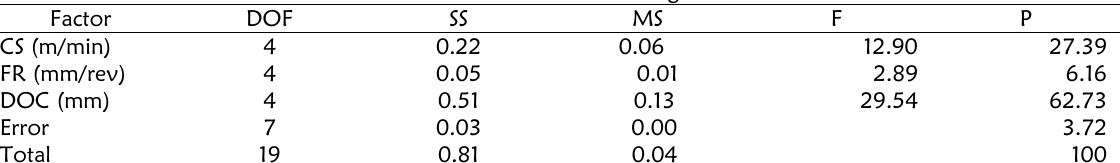
Table 12: ANOVA for surface roughness, Ra